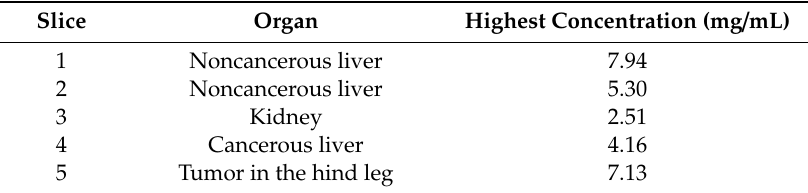
Table 1. Concentration of GdNPs in different organs.